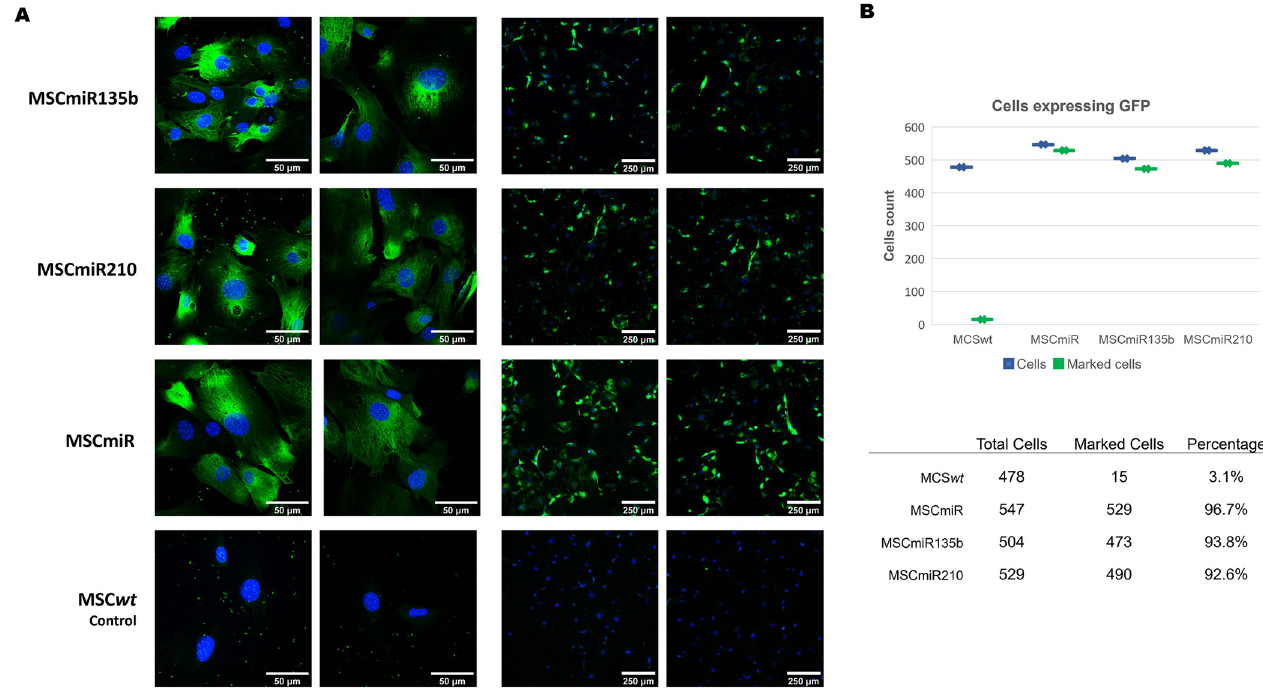
Fig 2. MSCs modified by a lentiviral vector. (A) Modified MSCs (MSCmiR135b, MSCmiR210 and MSCmiR) and MSC wt (control) in the immunofluorescence assay. The cell nucleus was stained with DAPI (in blue), and GFP was stained with anti-GFP antibody (in green). (B) Quantification of MSCs modified with a lentivector by counting of GFP+ cells per mm 2 of